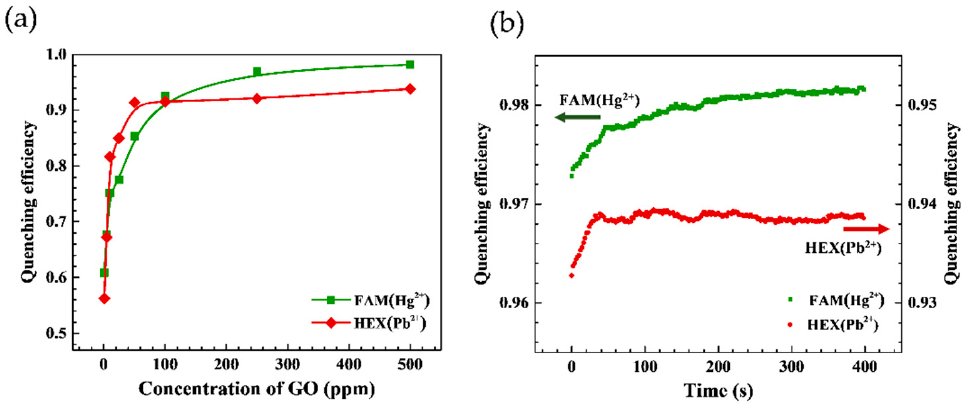
Figure 4. ( a ) Quenching efficiency for suspensions consisting of FAM(Hg 2+ )- and HEX(Pb 2+ )-labeled 100 nM aptamer and GO solution with concentration ranging from 1 to 500 ppm, and ( b ) long-term quenching efficiency of suspensions of FAM(Hg 2+ )- and HEX(Pb 2+ )-labeled aptamers and GO solution with concentration of 500 ppm.